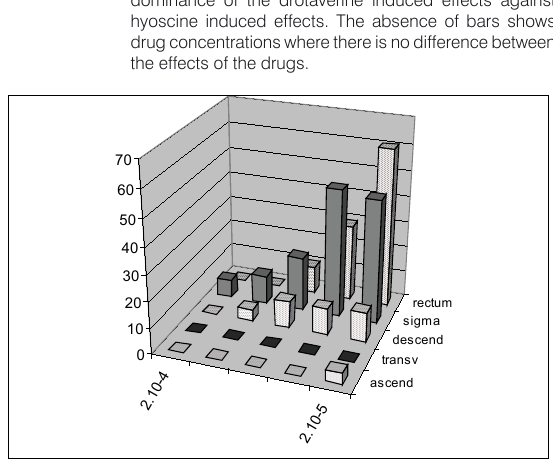
Figure 1. Comparison of the strength of the isometric registered inhibitory effects of drotaverine against hyoscine for frequency of the spontaneous phase contractions of SM colon samples. Every bar shows the degree of dominance of the drotaverine induced effects against hyoscine induced effects. The absence of bars shows drug concentrations where there is no difference between the effects of the drugs.